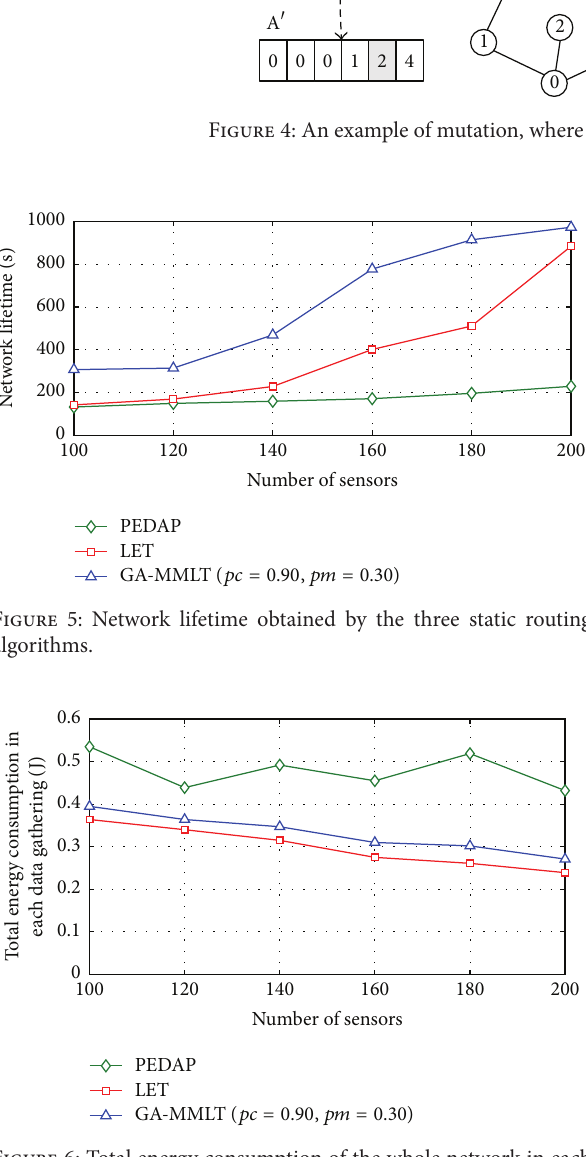
Figure 6: Total energy consumption of the whole network in each data gathering using three static routing algorithms.